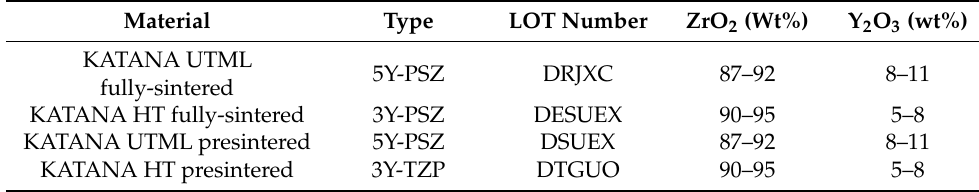
Table 1. LOT numbers of the used